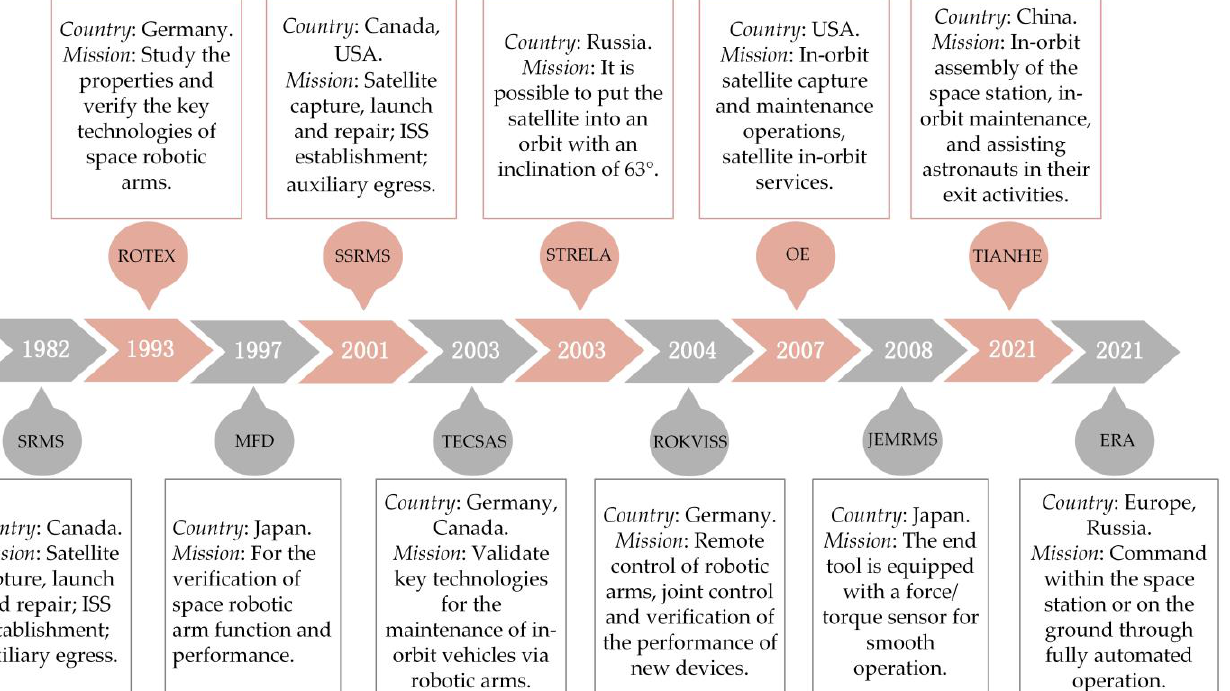
Figure 1. International Space Station robotic arm research and application.